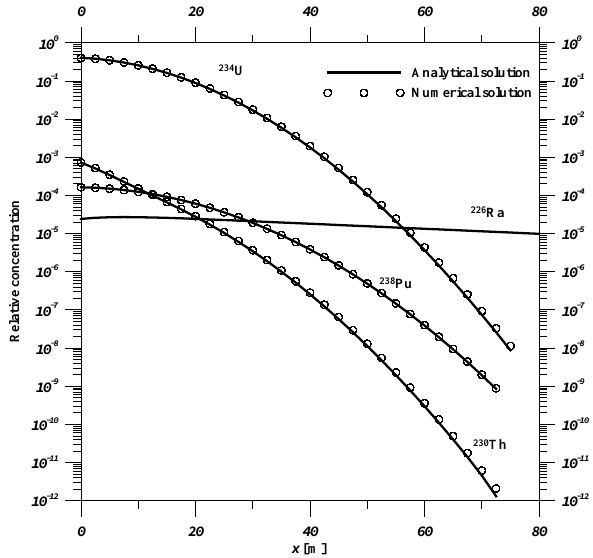
Fig. 2. Figure 2. Comparison of spatial concentration profiles of four species along the longitudinal direction ( = 50m) at t = 1000years obtained from derived analytical solutions and numerical solutions for convergence test example 1 of four-member radionuclide decay chain 238 Pu → 234 U → 230 Th → 226